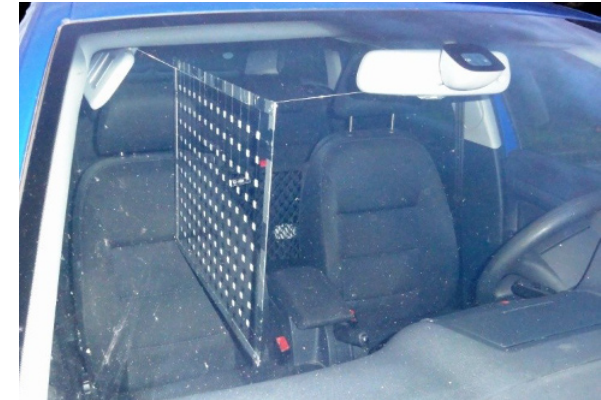
Fig. 9. The placement of measuring net in the front passenger